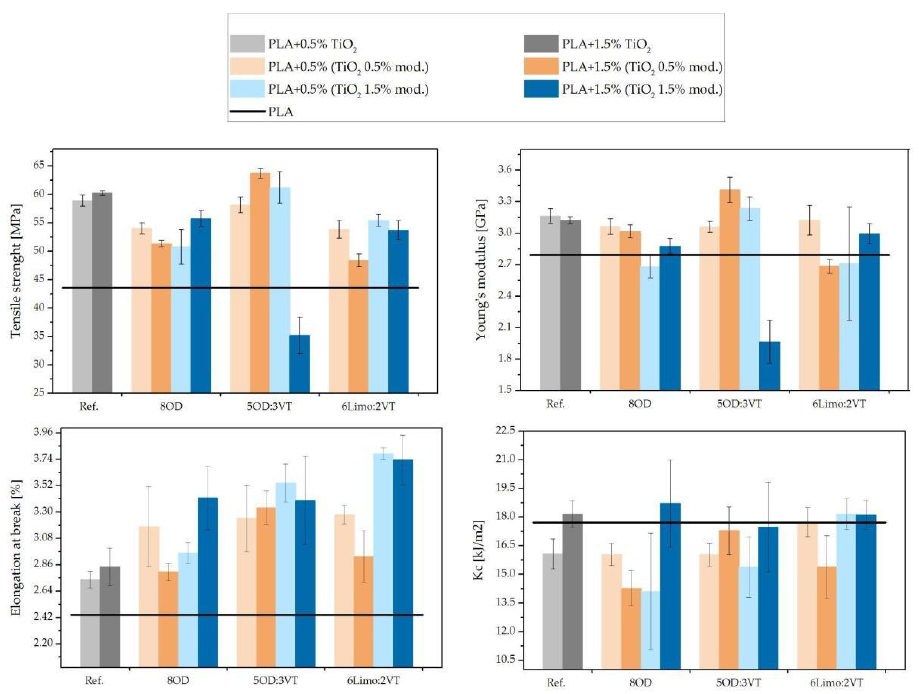
Figure 10. Tensile strength, Young’s modulus, elongation at break and impact strength (Kc) of tested sample.